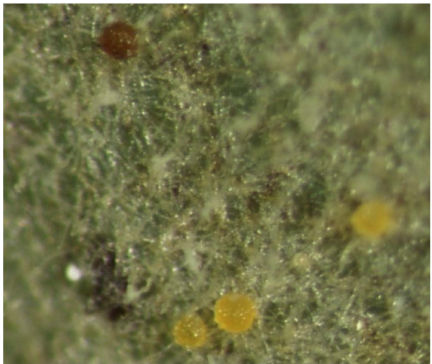
Figure 1. Chasmothecia on ‘Godello’ variety grapevine leaves.